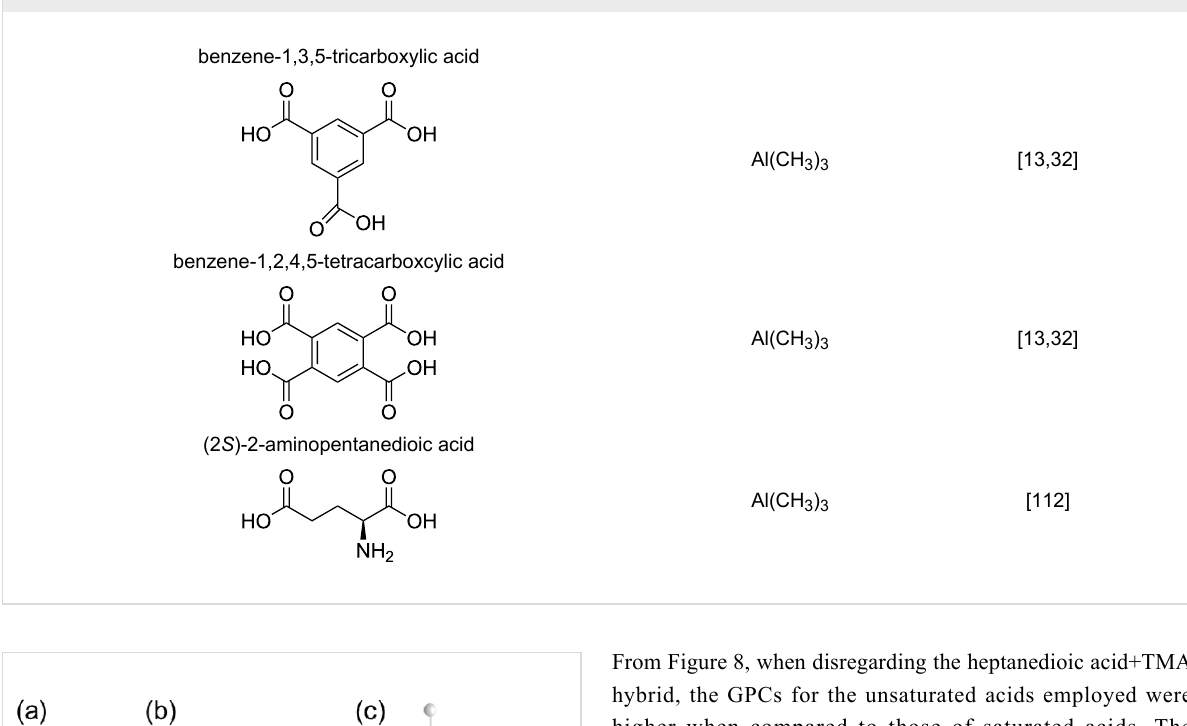
Table 12: Carboxylic acid precursors used to deposit inorganic–organic hybrid thin films. (continued)